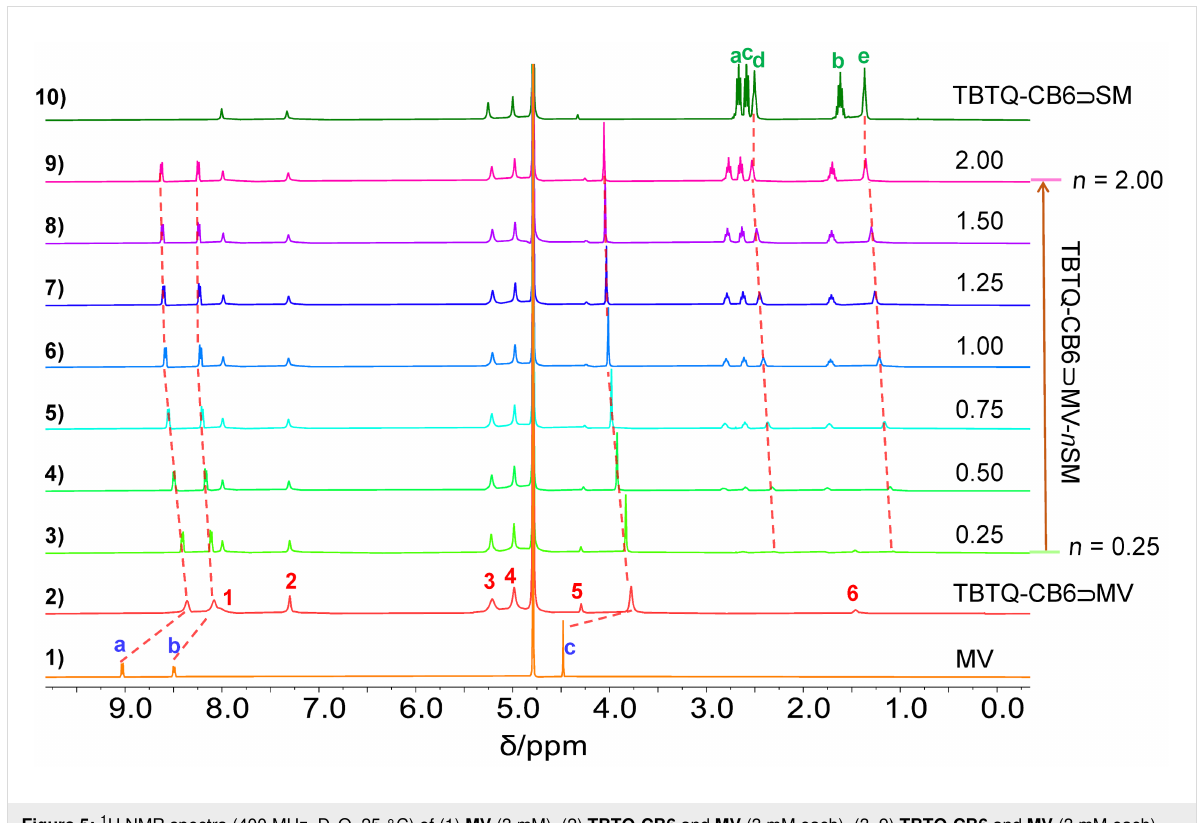
Figure 5: 1 H NMR spectra (400 MHz, D 2 O, 25 °C) of (1) MV (3 mM), (2) TBTQ-CB6 and MV (3 mM each), (3–9) TBTQ-CB6 and MV (3 mM each) with gradual addition of SM , and (10) TBTQ-CB6 and SM (3.0 mM each).